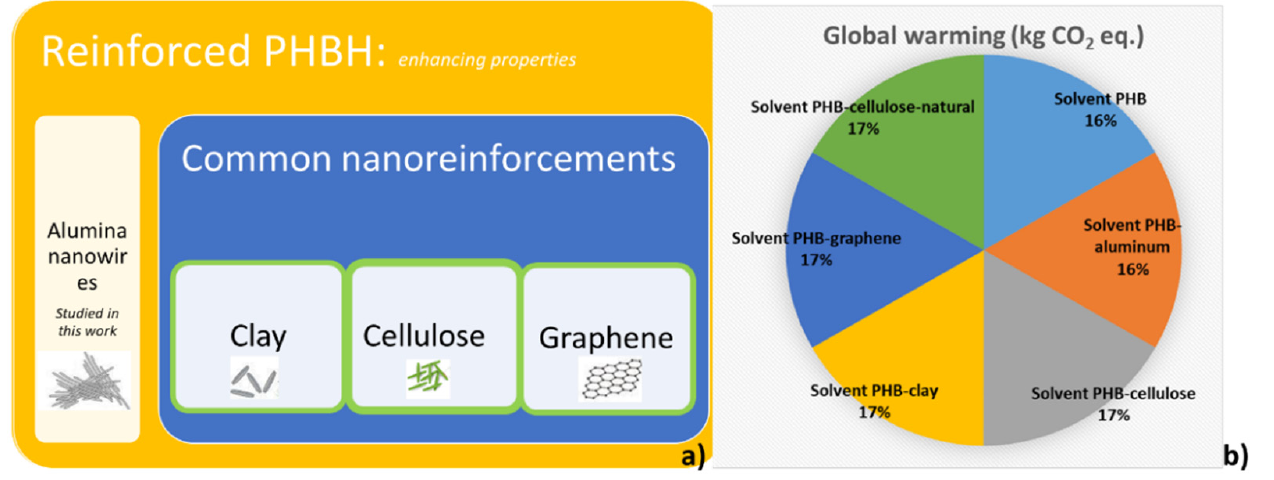
Figure 16. ( a ) Visual summary of the sensitivity analysis conditions to measure the effect of the different reinforcing particles (case “i”), and ( b ) the corresponding contribution of each case to the total global warming.